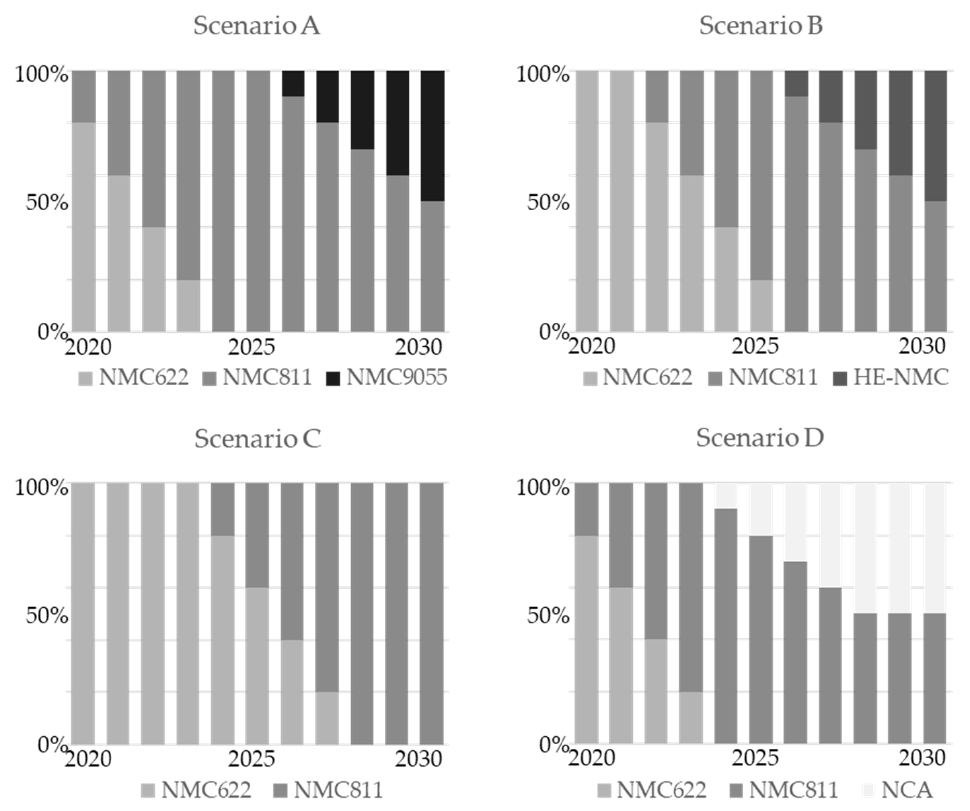
Figure 2. Four scenarios for cell-chemistry rollouts in the premium segment (data based on published study [19]) .